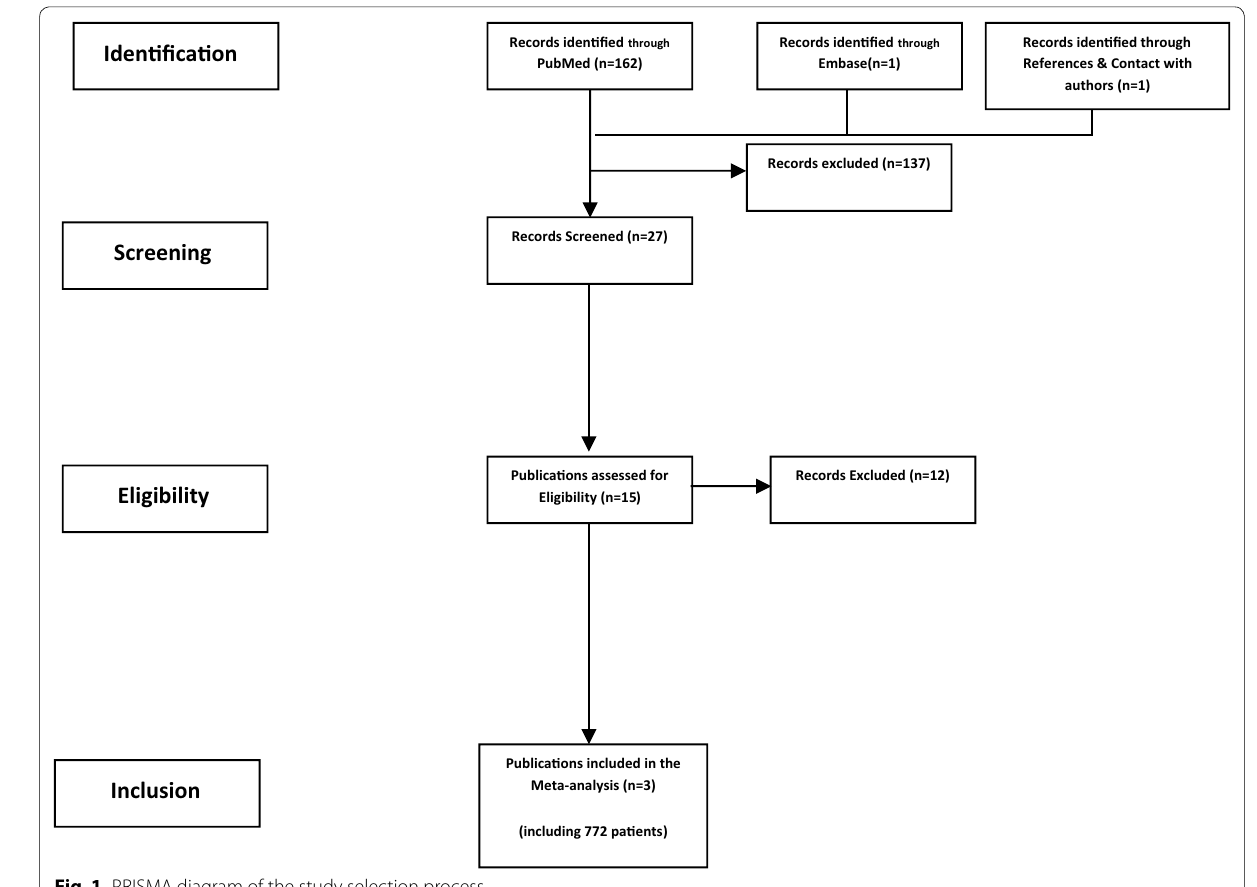
Fig. 1 PRISMA diagram of the study selection